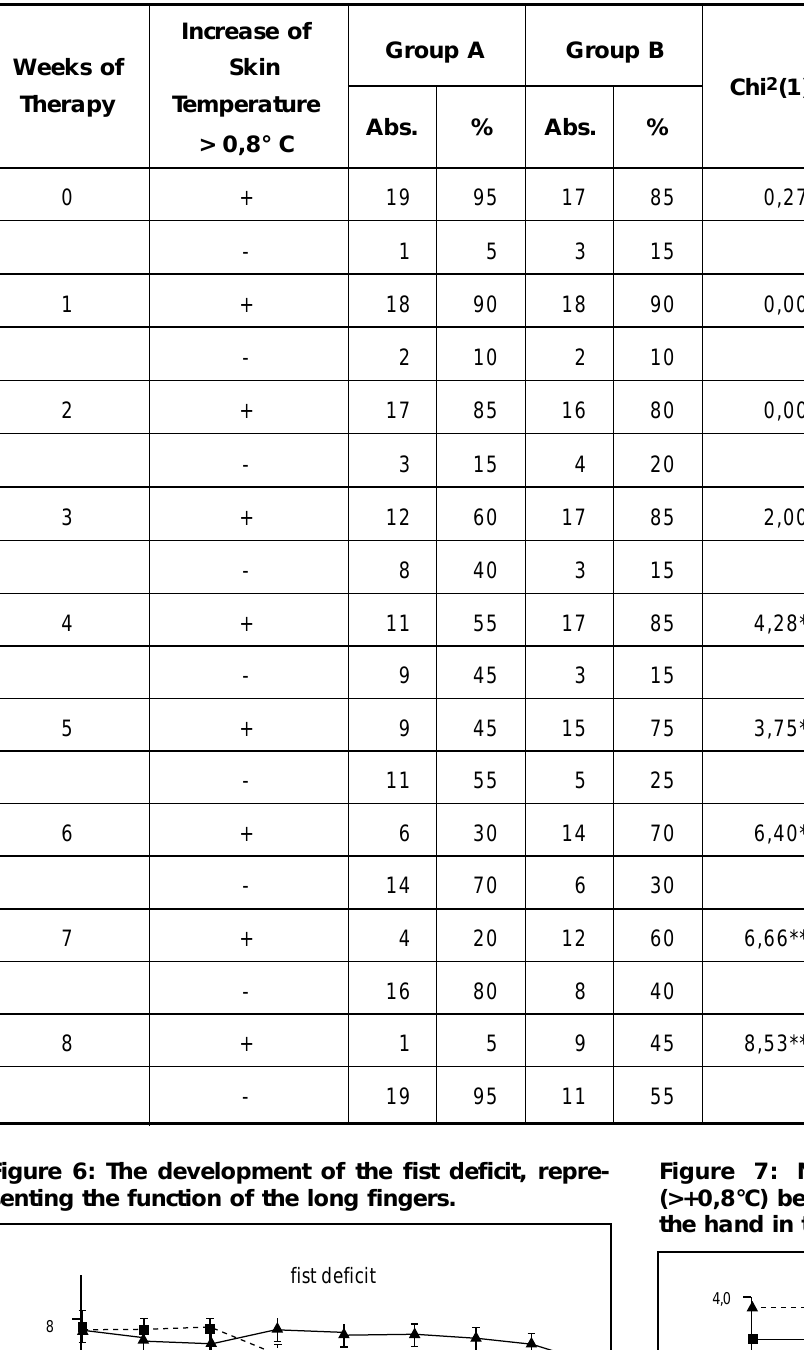
Table 5: Number of Patients with the Differences ( >0,8°C) between Sides for the Skin Temperature of the Hand in the Therapy Groups and their Changes in the Course of Eight